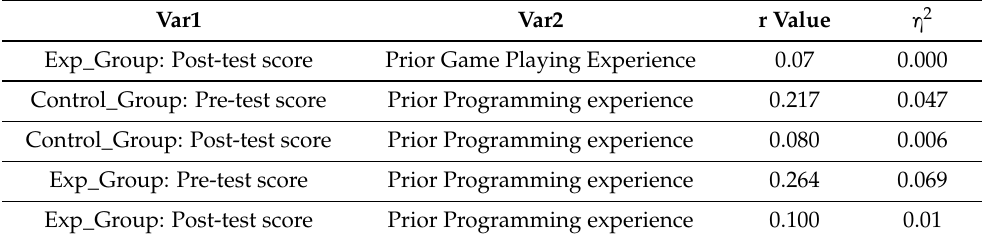
Table 2. Threats to the validity of the